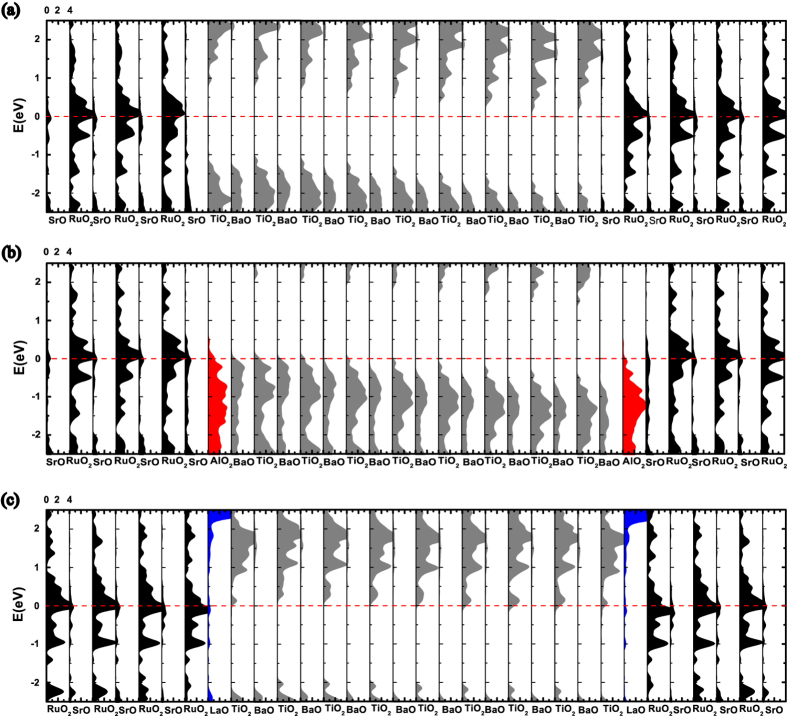
Layer-resolved DOS of FTJs (a) without insertion (structure SI), (b) with (AlO2)− insertion (structure SII), and (c) with (LaO)+ insertion (structure SIII).The horizontal red line denotes the Fermi energy.